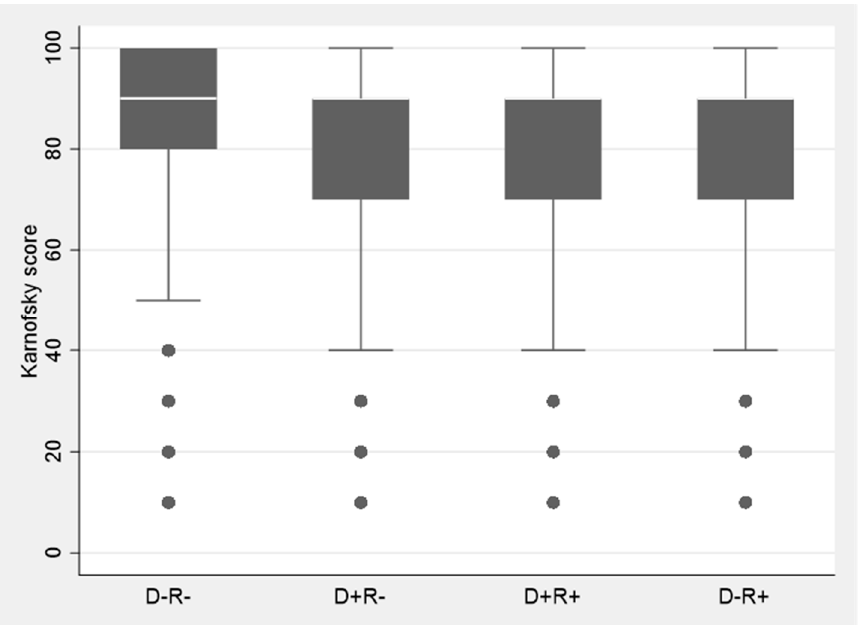
Figure 1. Functional status in each of four donor and recipient CMV serostatus groups. D = donor, R = recipient. CMV D-R- patients had the highest while D+R+ had the lowest functional level. D+R-, D+R+, D-R+ each had significantly lower Karnofsky score than D-R- patients ( p < 0.005).